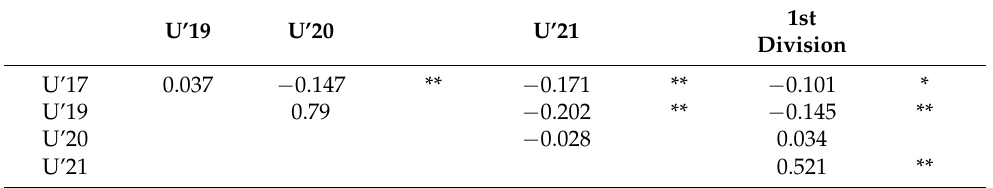
Table 3. Correlation Coefficient of different categories of Spanish national teams and first division